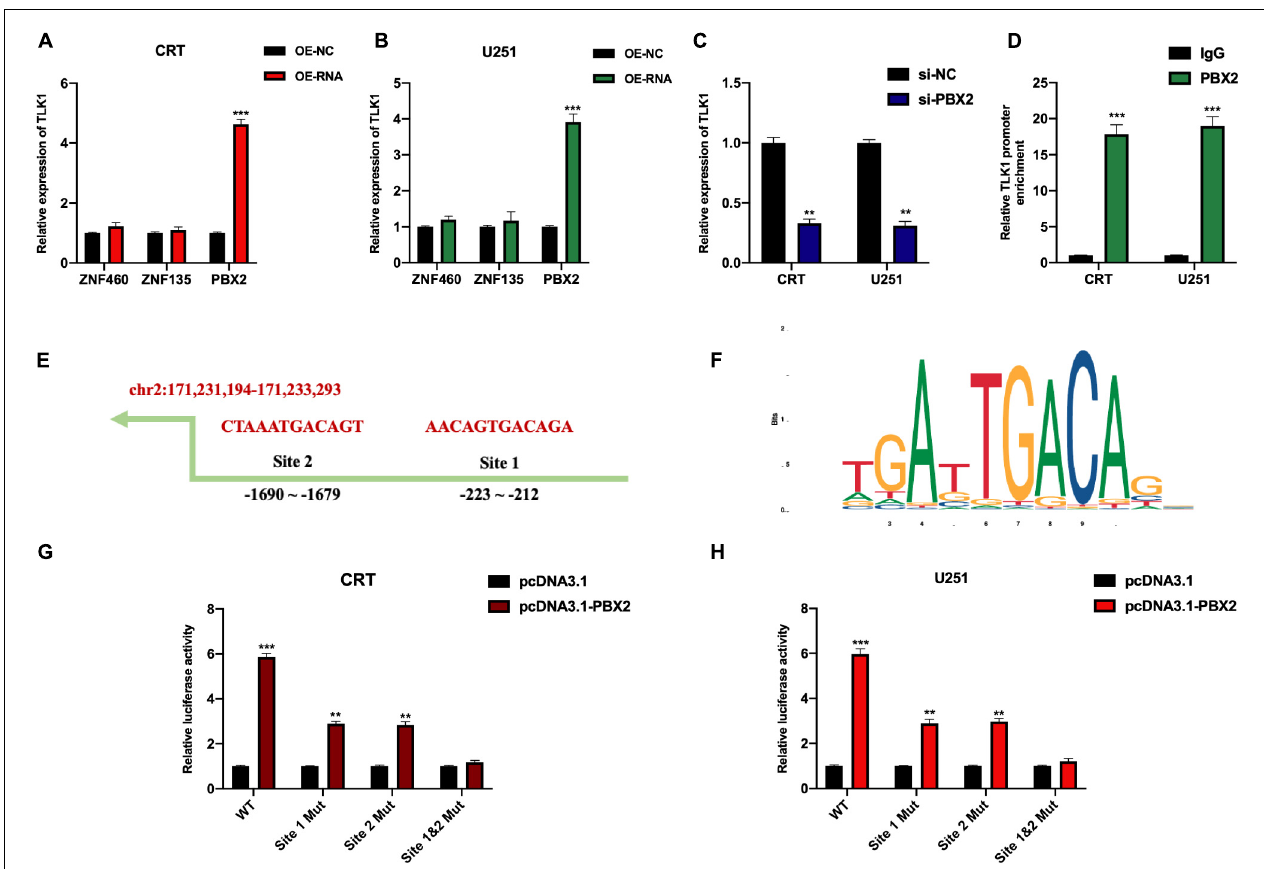
FIGURE 8 | CircTLK1 expression is mediated by PBX2. CRT and U251 cells were stably infected with OE-NC, OE-RNAs, si-NC, and si-PBX2, as indicated. (A,B) Relative expression of circTLK1 in (A) CRT and (B) U251 cells pretreated with OE-NC and OE-RNAs was measured using qRT-PCR. (C) Relative expression of circTLK1 in CRT and U251 cells pretransfected with si-NC and si-PBX2 was detected using qRT-PCR. (D) ChIP assay was performed using anti-IgG and anti-PBX2; results were detected using the qRT-PCR assay. (E) The predicted binding sites of circTLK1 promoter were obtained from the JASPAR dataset. (F) The predicted binding sequence of PBX2 was collected from the JASPAR dataset. (G,H) The impact of PBX2 on circTLK1 transcription in (G) CRT and (H) U251 cells was assessed using luciferase reporter assay. **p < 0.01, ***p <